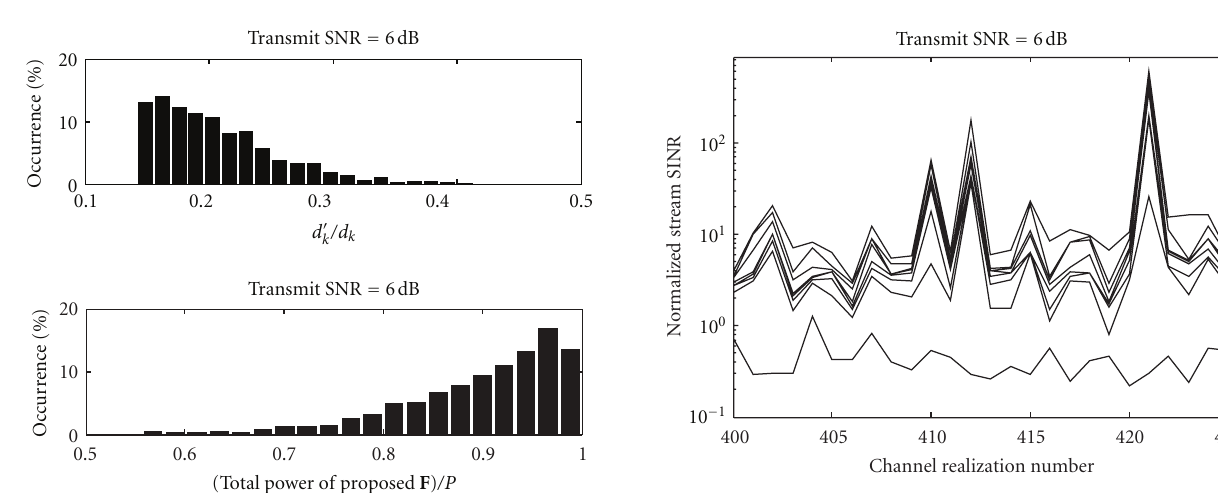
Figure 3: Eight-antenna example. Top: Histogram of the ratio between d k (cid:11) (after the fix) and d k . Bottom: histogram of the ratio between the total power of the proposed F and P .